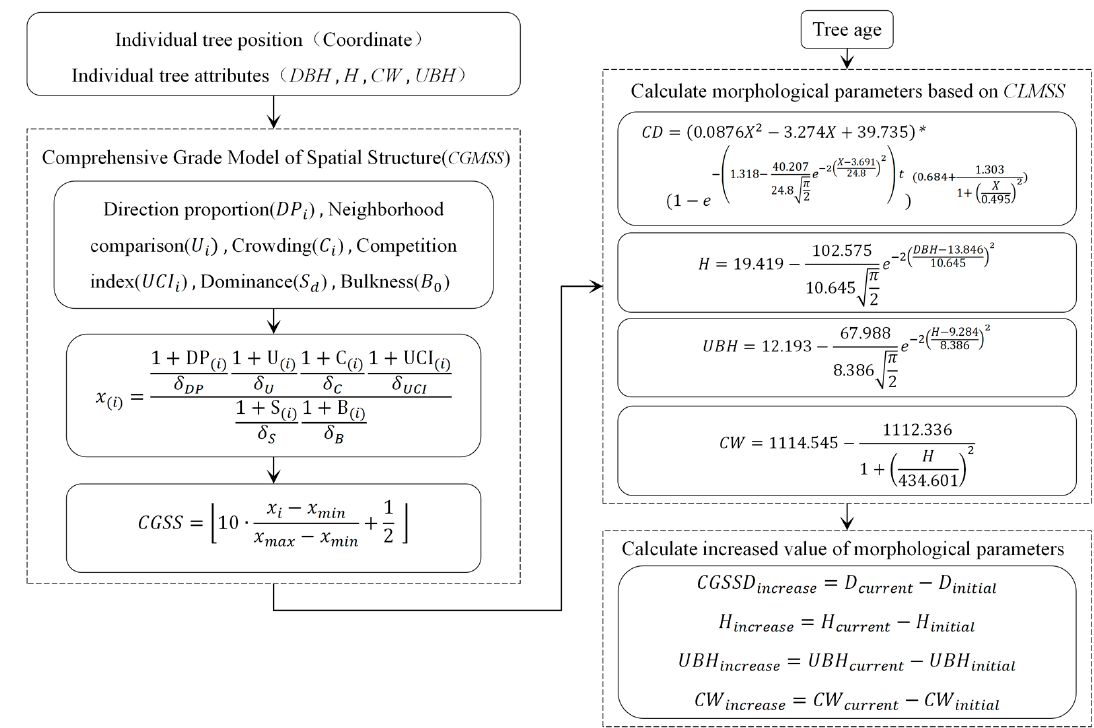
Figure 11. The calculation process of morphological structure parameter values of Chinese fi r.